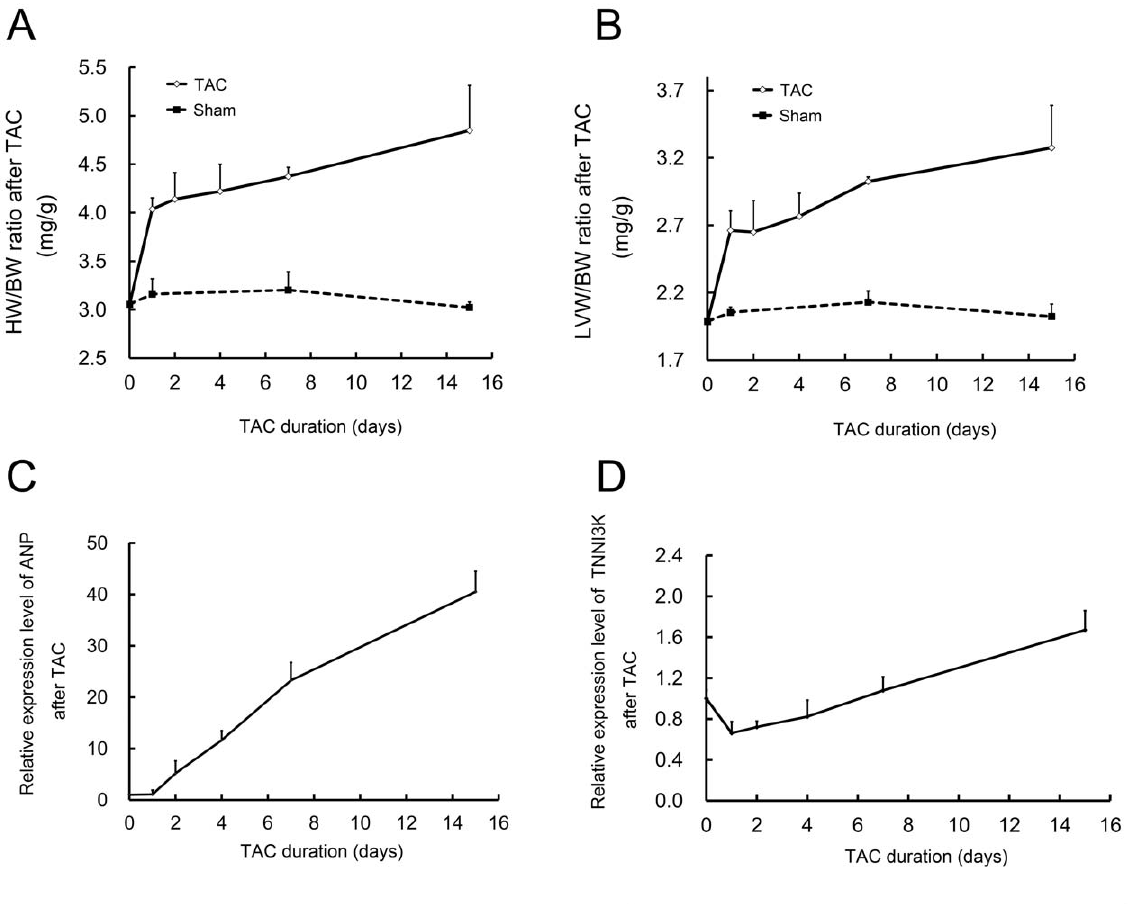
Figure 1. TNNI3K expression was dynamically regulated in the hypertrophic hearts in rats. A and B: the heart weight/body weight (HW/ BW) and left ventricular weight/body weight (LVW/BW) were continuously increased after TAC. Five different time points were analyzed for TAC group and 3 different time points for sham operation group. Each time point included 4–5 animals. C and D: The expression of ANP and TNNI3K were detected by real-time PCR analysis. Gapdh was used for internal control and data were presented as fold-change compared with that of sham operation controls. Five different time points were analyzed (1, 2, 4, 7, 15 days post-operation, respectively). Each time point contained 4–5 animals.